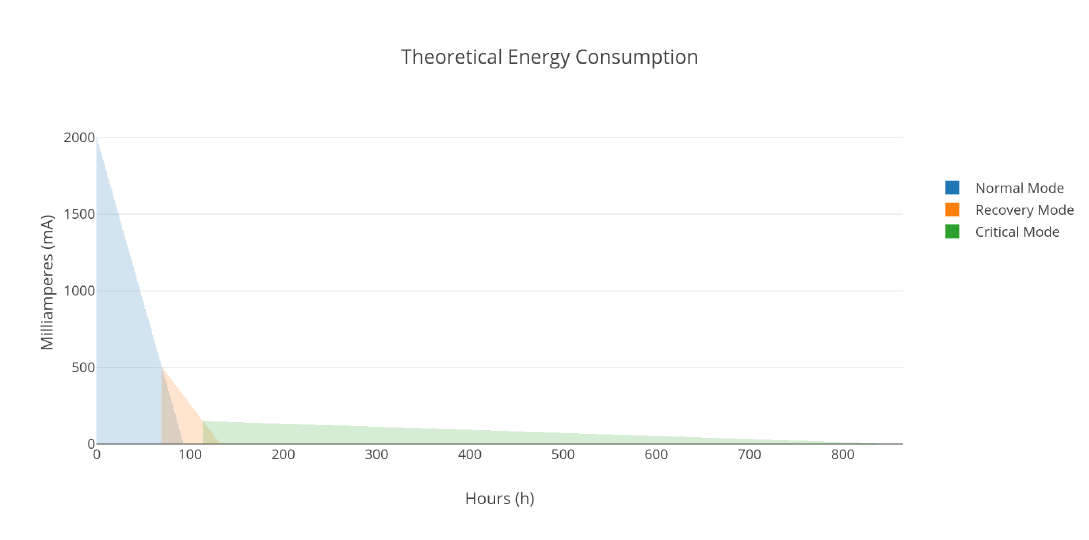
Figure 9. Theoretical energy consumption without solar